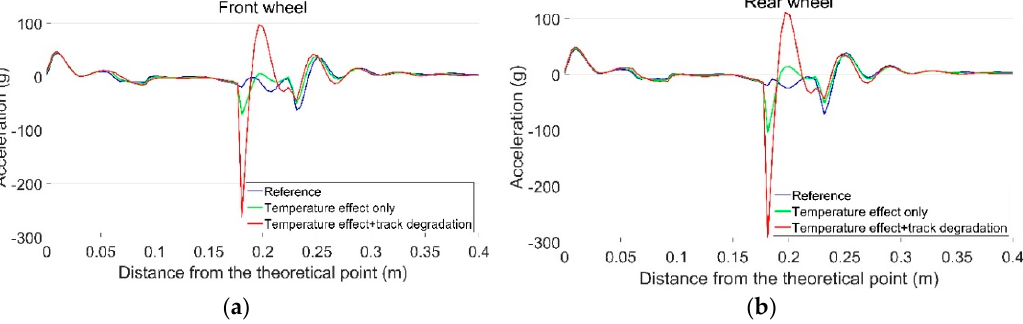
Figure 22. Vertical rail accelerations due to passing wheels. ( a ) Front wheel; ( b ) rear wheel.